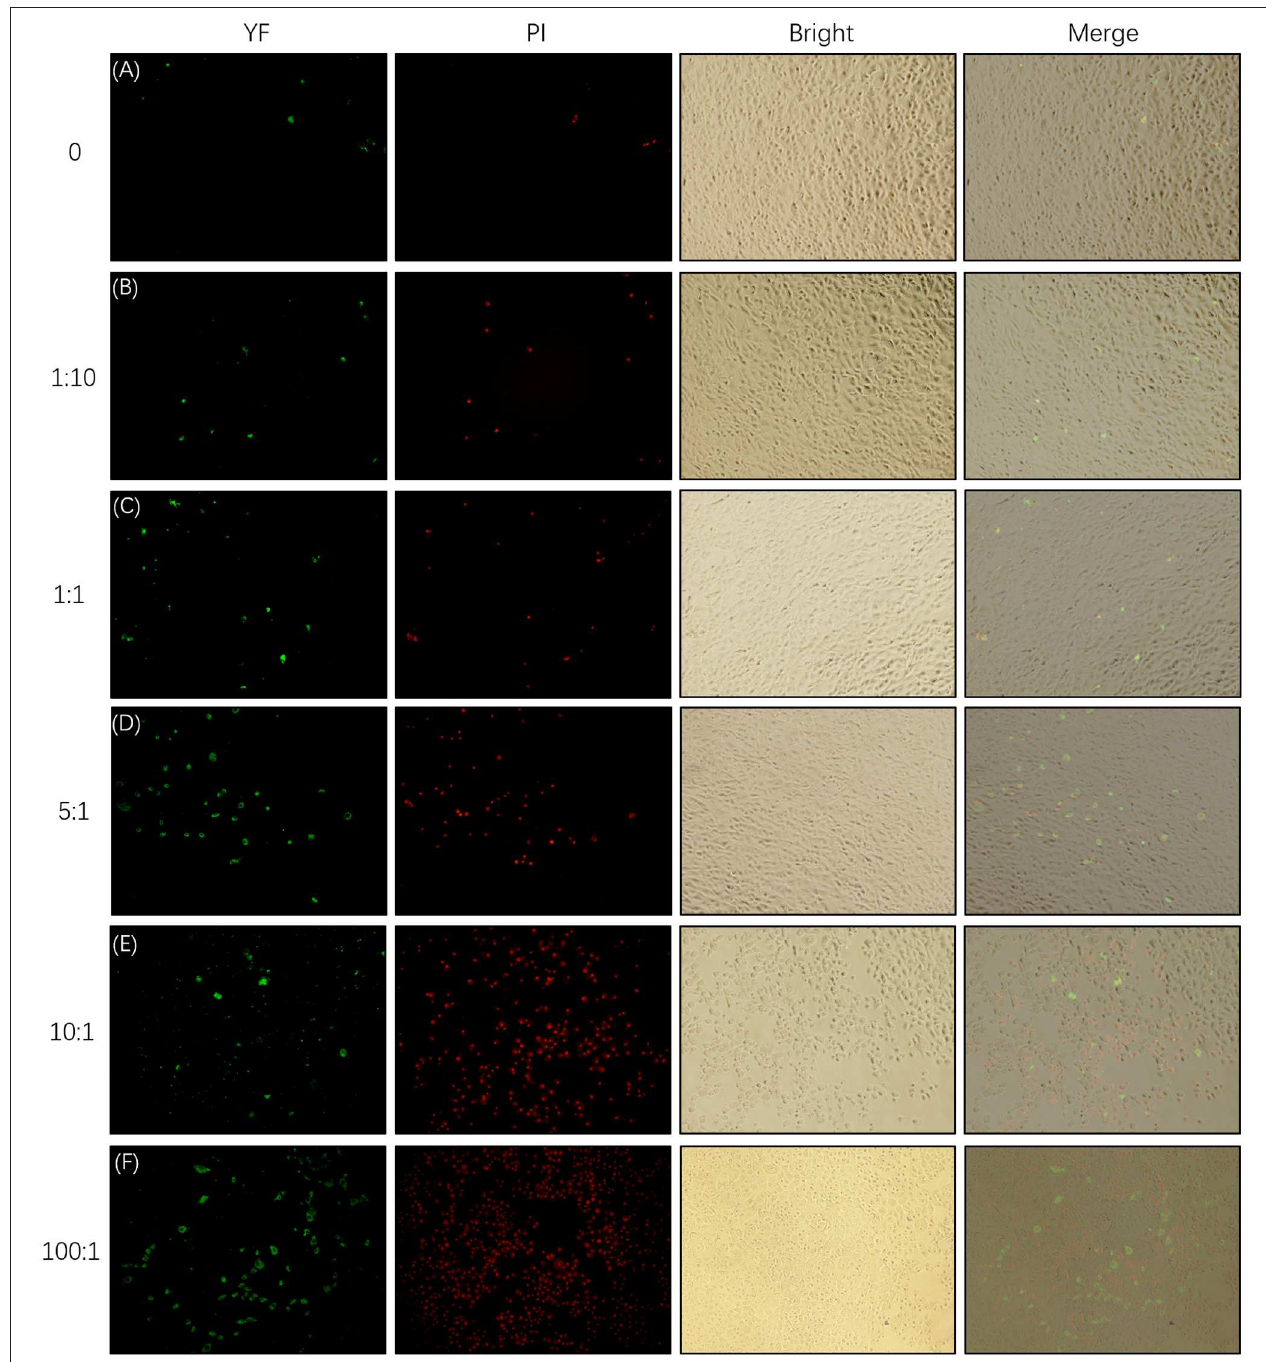
FIGURE 6 | Apoptosis and necrosis of SEECs tested by YF-Annexin V and PI Apoptosis Kit. The SEECs were non-treated or treated with five different MOIs of E. coli for 3h, followed by apoptosis and necrosis assays. Green fluorescence showed the apoptotic cells which were combined with YF-Annexin V, and red fluorescence showed the dead cells which were combined with PI. (A) Apoptosis and necrosis of SEECs in the non-infecting group. (B) Apoptosis and necrosis of SEECs infected by E. coli at the MOI of 1:10. (C) Apoptosis and necrosis of SEECs infected by E. coli at the MOI of 1:1. (D) Apoptosis and necrosis of SEECs infected by E. coli at the MOI of 5:1. (E) Apoptosis and necrosis of SEECs infected by E. coli at the MOI of 10:1. (F) Apoptosis and necrosis of SEECs infected by E. coli at the MOI of 100:1.